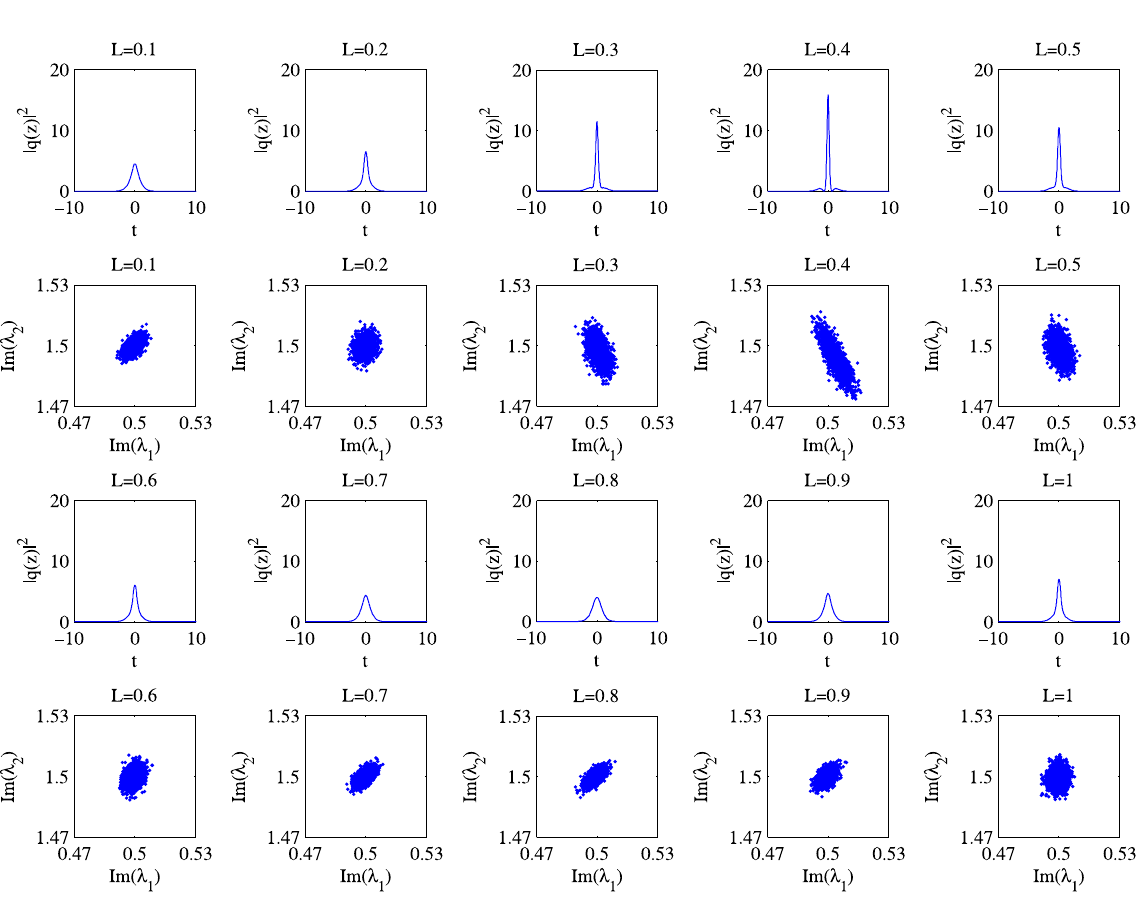
Figure 6. Scattering plot for Λ ˆ at different normalized propagation lengths: 0.1, 0.2, 0.3, … , 0.9, m